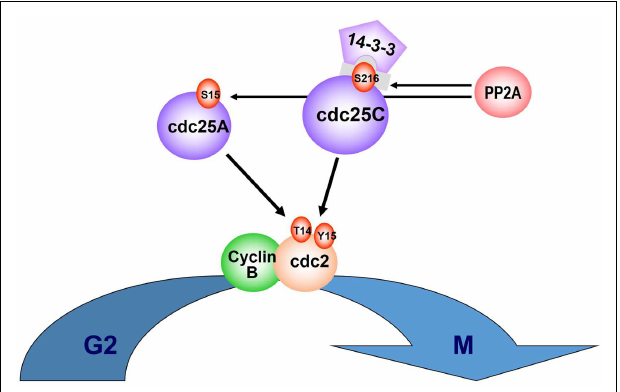
FIGURE 1 | CDC25C and PP2Ac α regulatory role on cell cycle . Entry into mitosis is mediated via PP2A dephosphorylation of Cdc25C, at the regulatory serine substrate (Ser 216 ), leading to 14-3-3 displacement and nuclear translocation of the CyclinB/cdc2 complex. PP2A also regulates phosphorylation of Cdc25A at Ser 15 . Phosphorylation of tyrosine (Tyr 15 ) and threonine (Thr 14 ) residues within the ATP binding domain of cyclin-dependent kinase-1 (CDK-1, or cdc2) inhibit CDK-1/Cyclin B complexes and cell-cycle progression from G 2 to